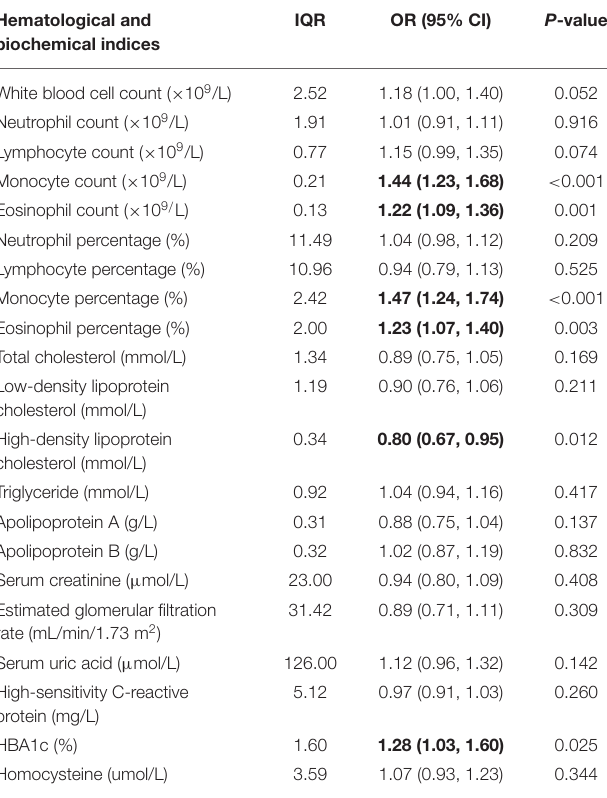
TABLE 2 | OR (95%CI) of ISR associated with per interquartile range (IQR) increment of each hematological and biochemical index * . Hematological and biochemical indices